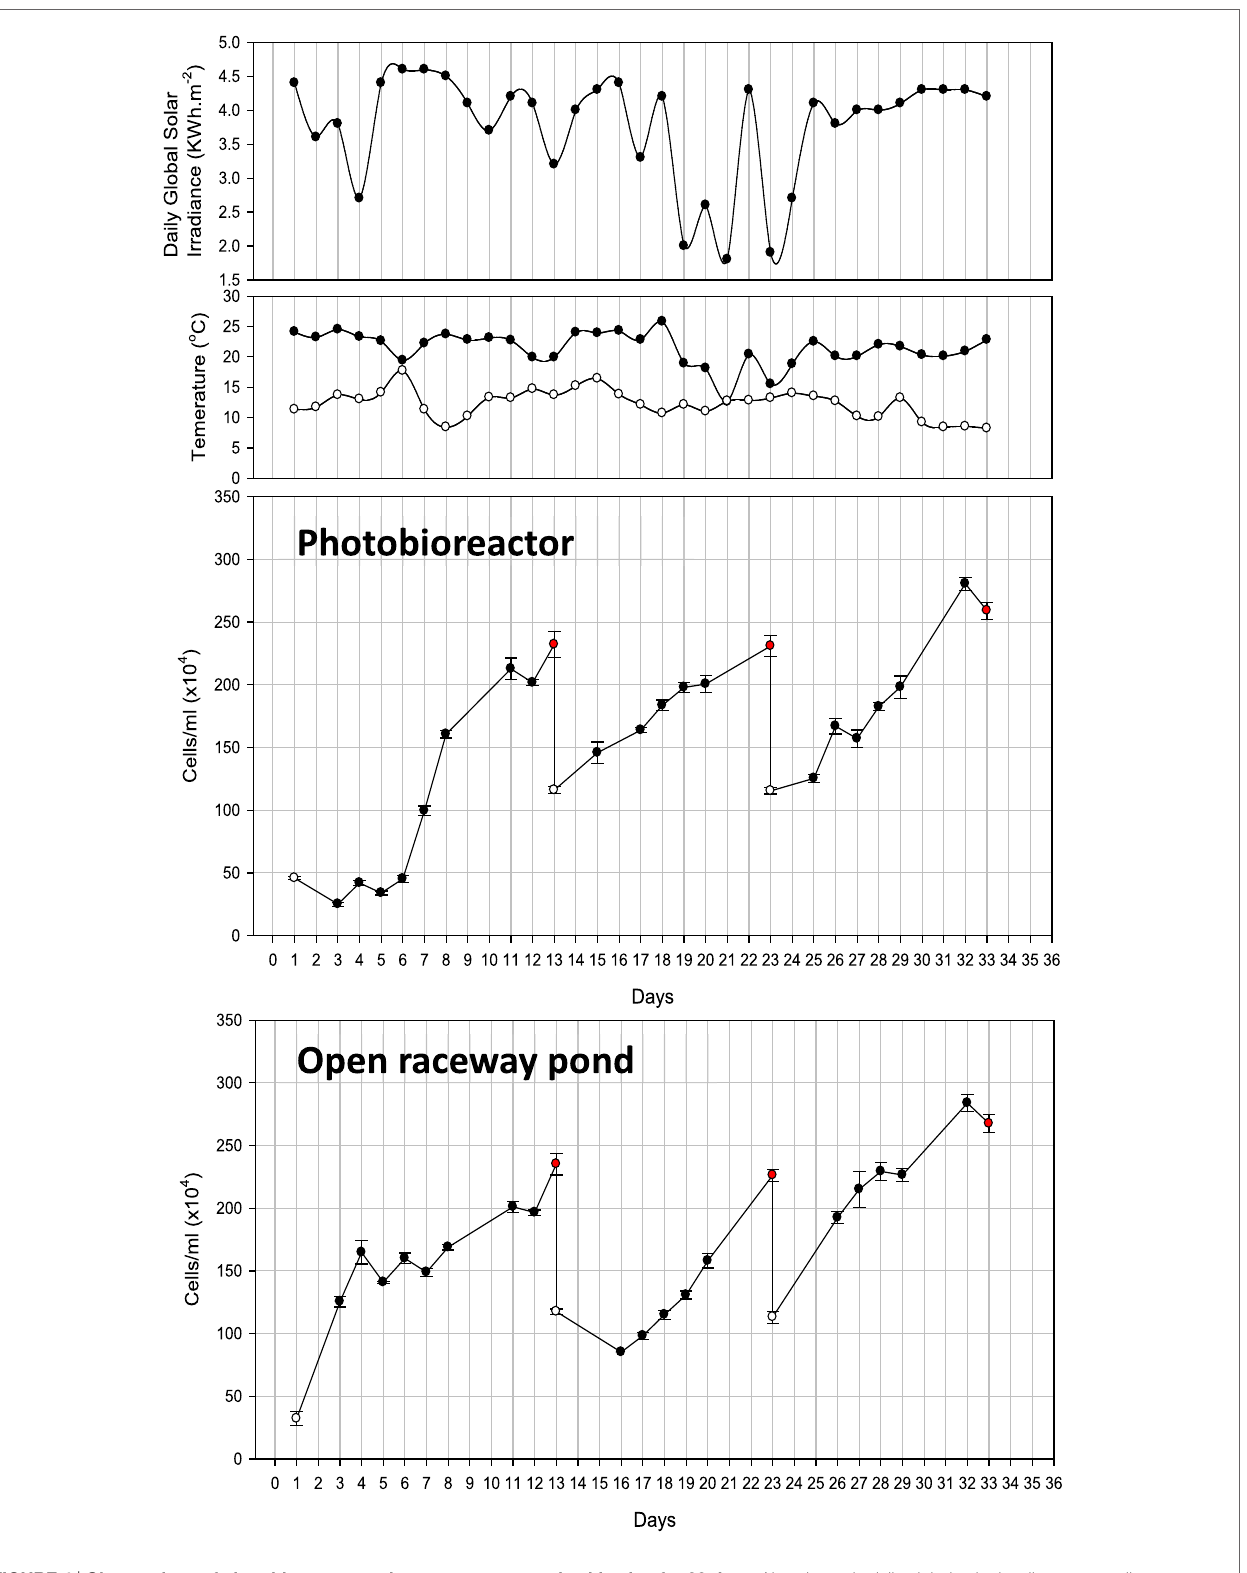
FigUre 4 | Observations of photobioreactor and open raceway pond cultivation for 33 days . Also shown is daily global solar irradiance, as well as minimum and maximum air temperature recorded for the respective day. White and red dots represent the start and finish of each cycle.